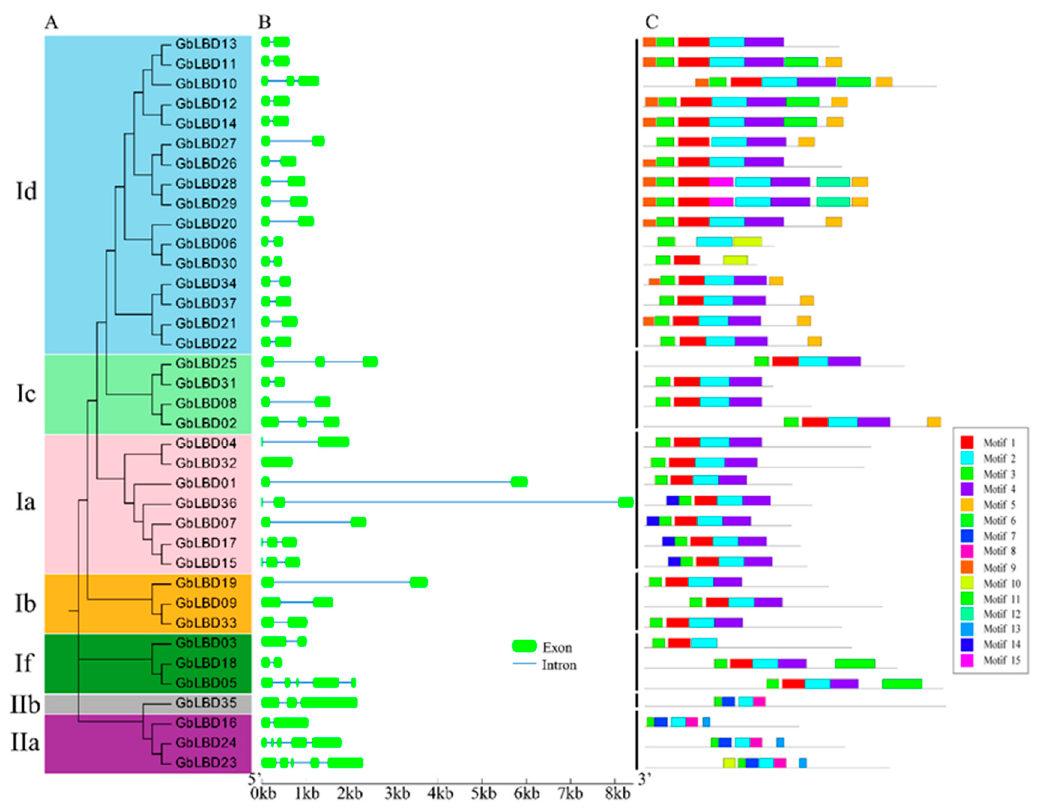
Figure 5. ( A ) Maximum likelihood tree for the GbLBD protein family. Different colors represent different subclasses. ( B ) Exon–intron structure of GbLBD genes. Scale bar indicates 1 kb. ( C ) Distribution of 15 motifs in 37 GbLBD proteins.